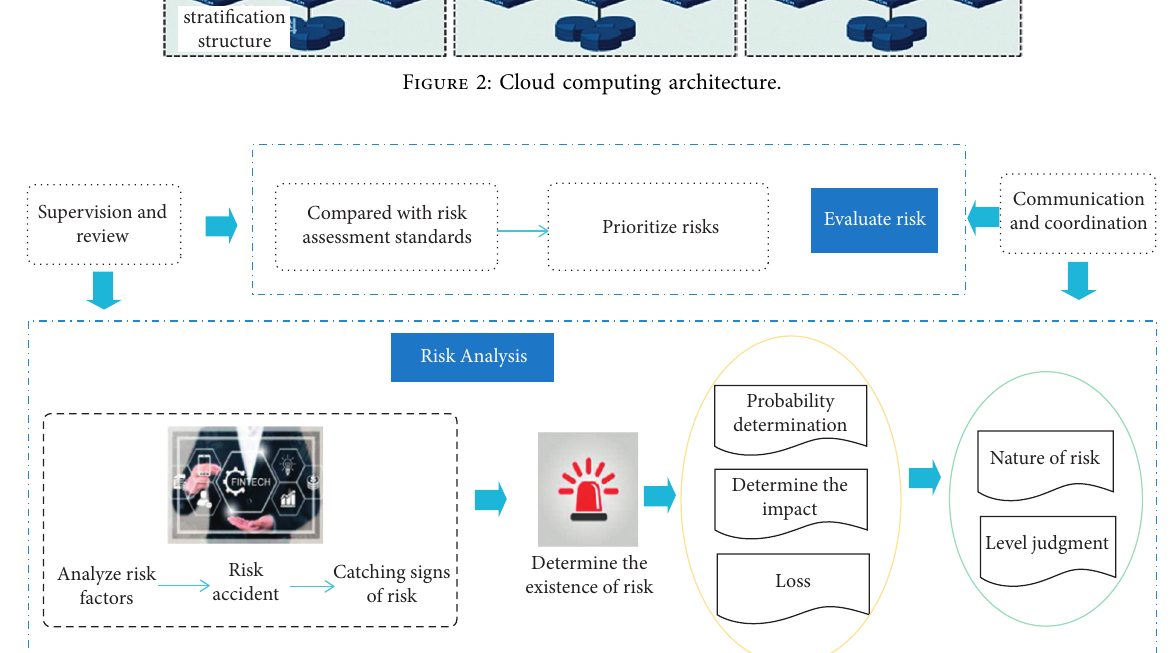
Figure 3: The financial credit risk analysis process of the Internet of